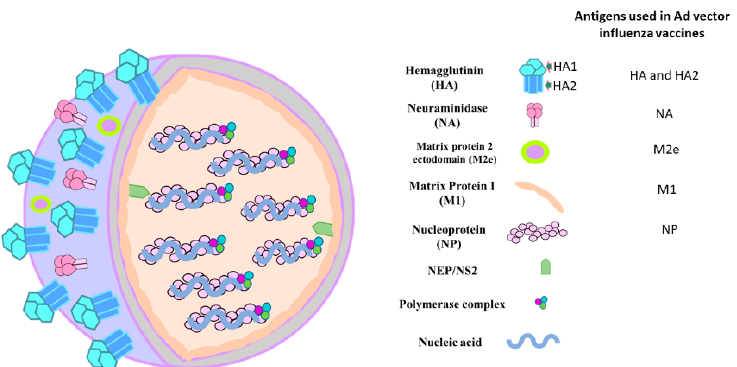
Figure 2. Diagrammatic sketch of influenza A virus structure. The influenza A virus is composed of eight segments of negative-sense ribonucleic acid (RNA) coupled with nucleoprotein (NP). The internal proteins include polymerase complex, nuclear export protein (NEP), and matrix 1 (M1) protein. The surface proteins are hemagglutinin (HA), neuraminidase (NA), and matrix 2 (M2) protein.